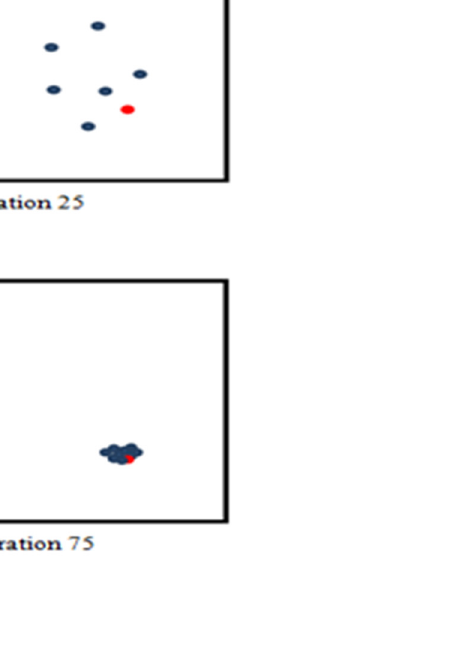
Fig 4. Particle Swarm Optimization movement towards global optima over iteration numbers